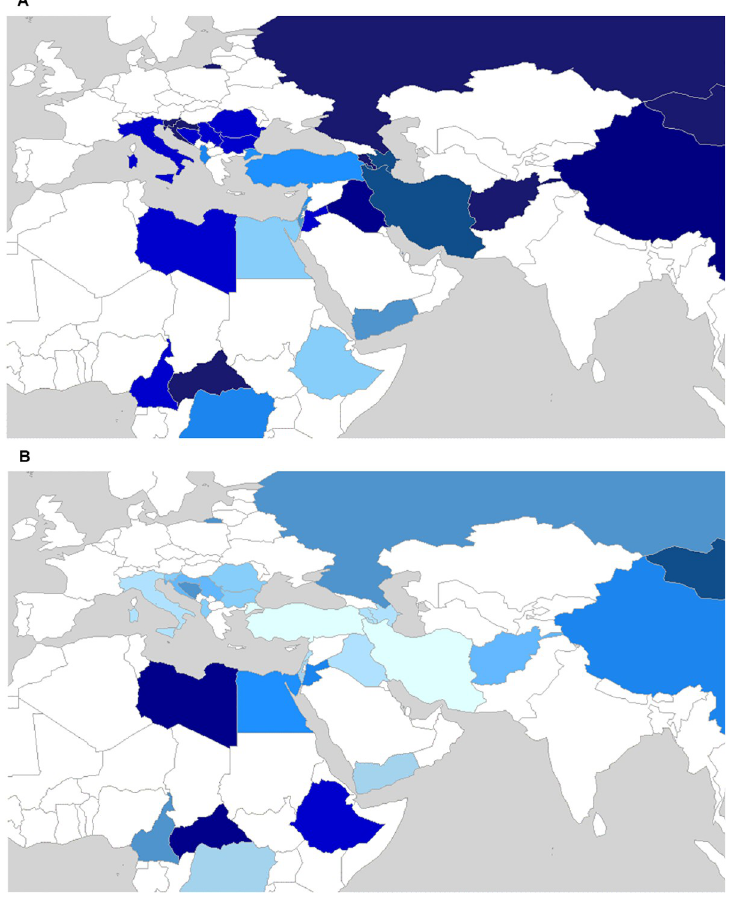
Fig 2. Contour maps based on the additional calculated pairwise genetic distances. (A) Pairwise genetic distances compared with Maronite Cypriots (B) Pairwise genetic distances compared with Armenian Cypriots. The colour scale indicates the range of the Rst values; the lower the colour intensity is, the lower the genetic differentiation between populations. Light blue indicates low genetic differentiation with values in the range 0–0.05 while dark blue indicates great genetic differentiation with values greater than